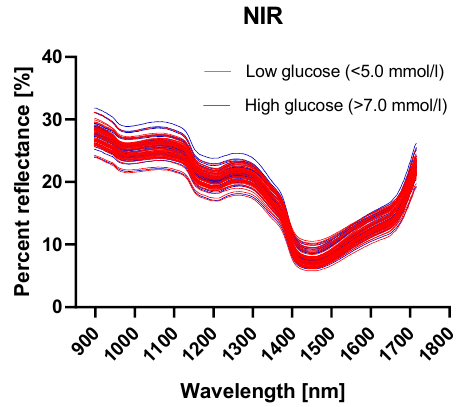
Fig.1: Unprocessed NIR spectra for glucose levels below 5.0 mM (blue lines) or above 7.0 mM (red lines).